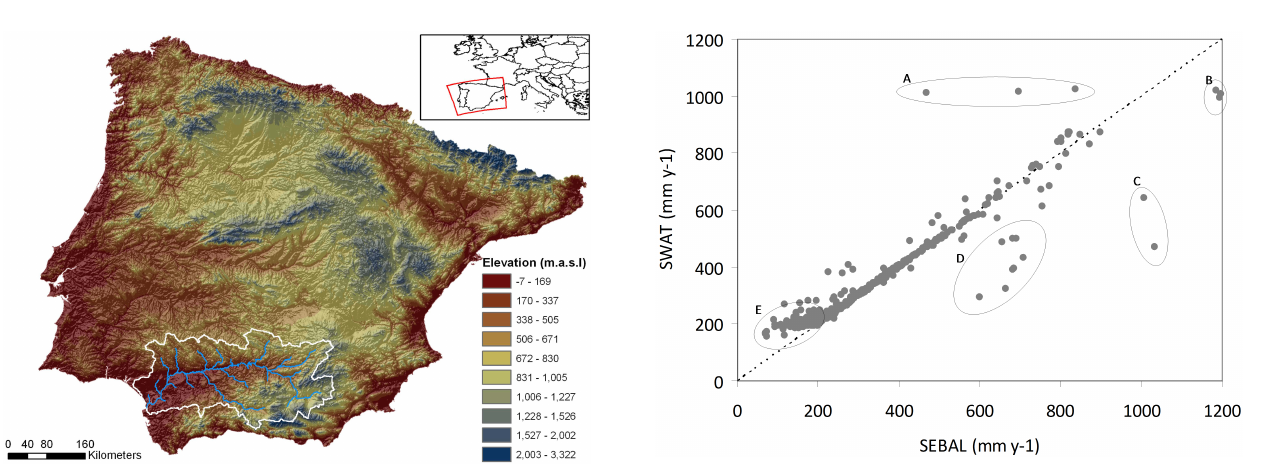
Fig. 9. Comparison observed (SEBAL) and modelled (SWAT) cal- ibration results. Ellipses A to E show areas where model differs from